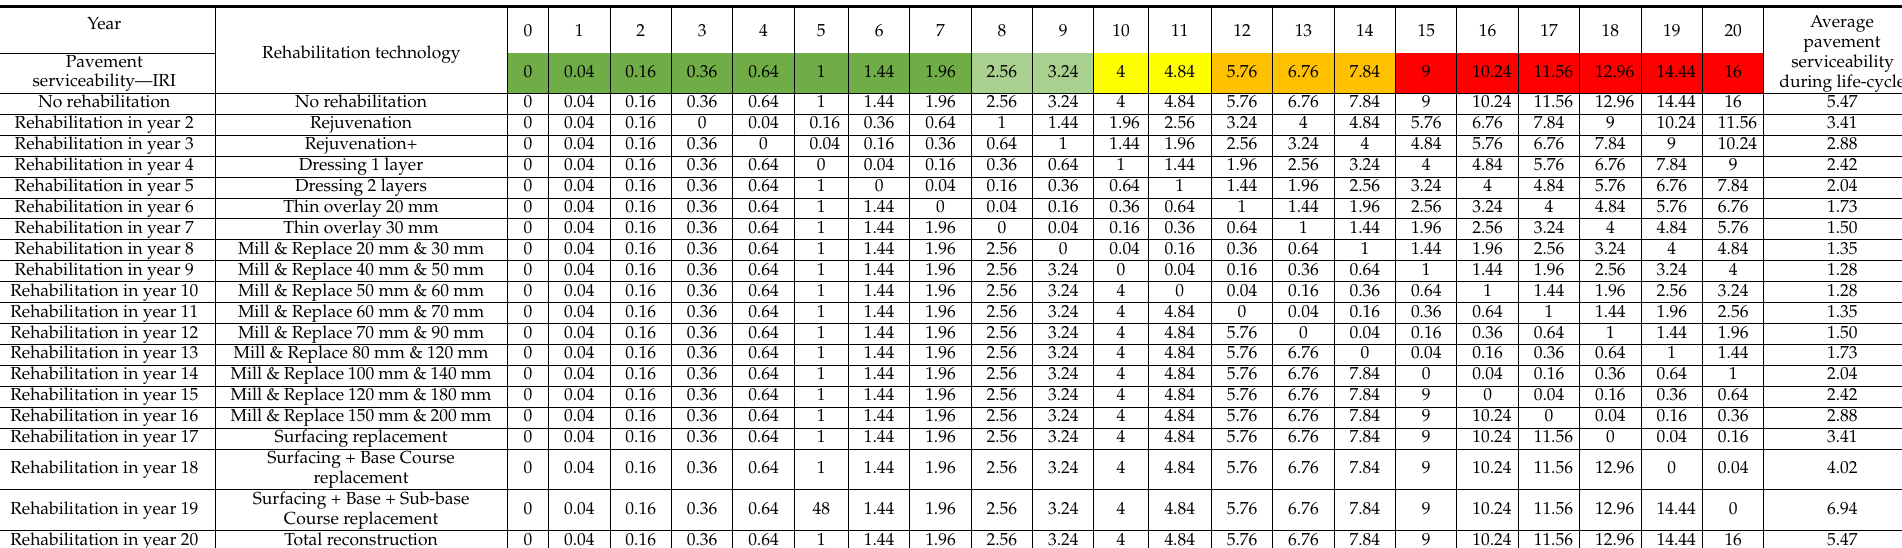
Table 3. Pavement serviceability—case